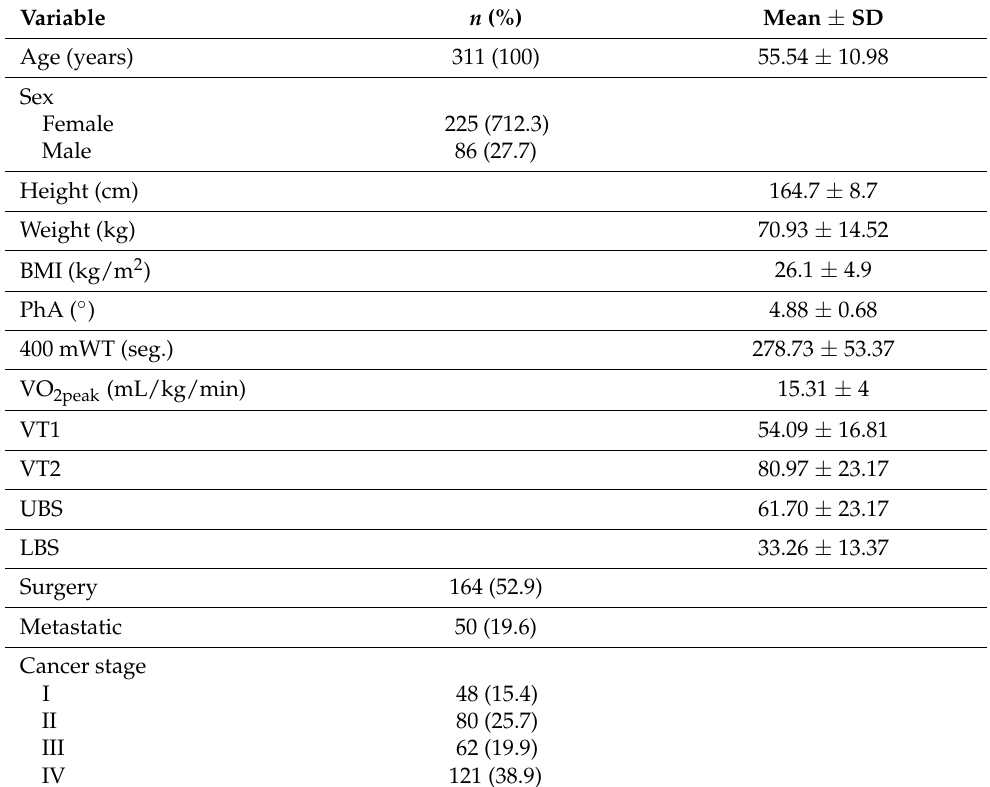
Table 1. Characteristics of the sample. Data is shown as mean ± standard deviation (SD) or percent- age (%).